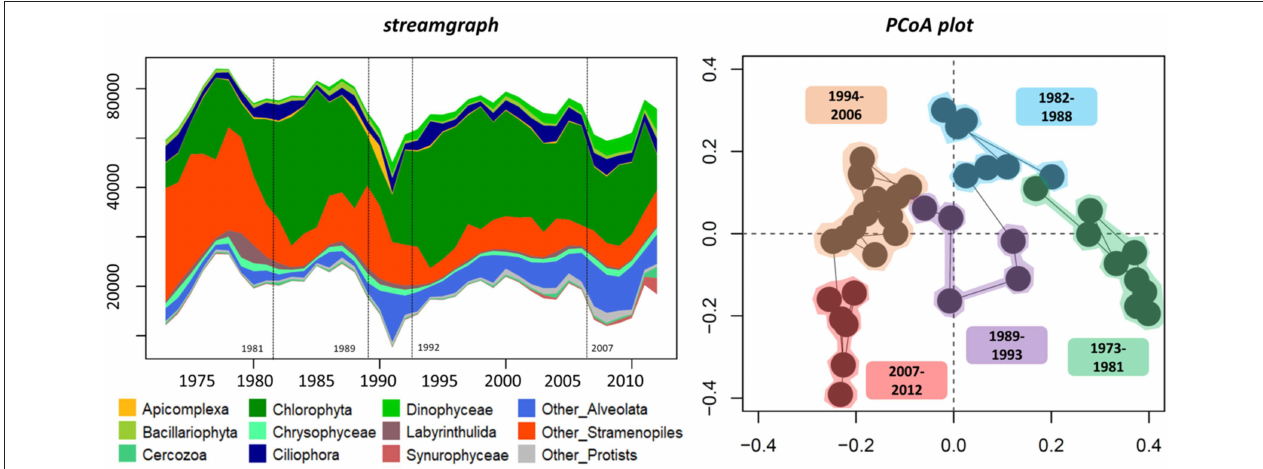
FIGURE 3 | Temporal changes in relative abundance of protistan groups (streamgraph) and the structure of the protistan community from 1973 to 2012 ordination plot based on the first two principal coordinates of the PCoA. Change points are indicated in the streamgraph by dashed lines. The PCoA plot is based on Bray-Curtis indices calculated from the OTU relative abundance table. Sample groups were identified using a hierarchical clustering tree-based analysis.